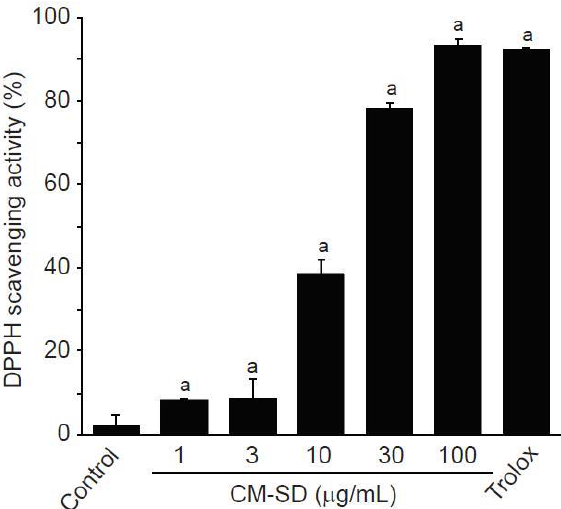
Figure 2. DPPH scavenging activity of curcumin 40% spray dry powders (CM-SD). Values are expressed as mean ± SD of three separate experiments. a p < 0.01, significant as compared with control by LSD test.